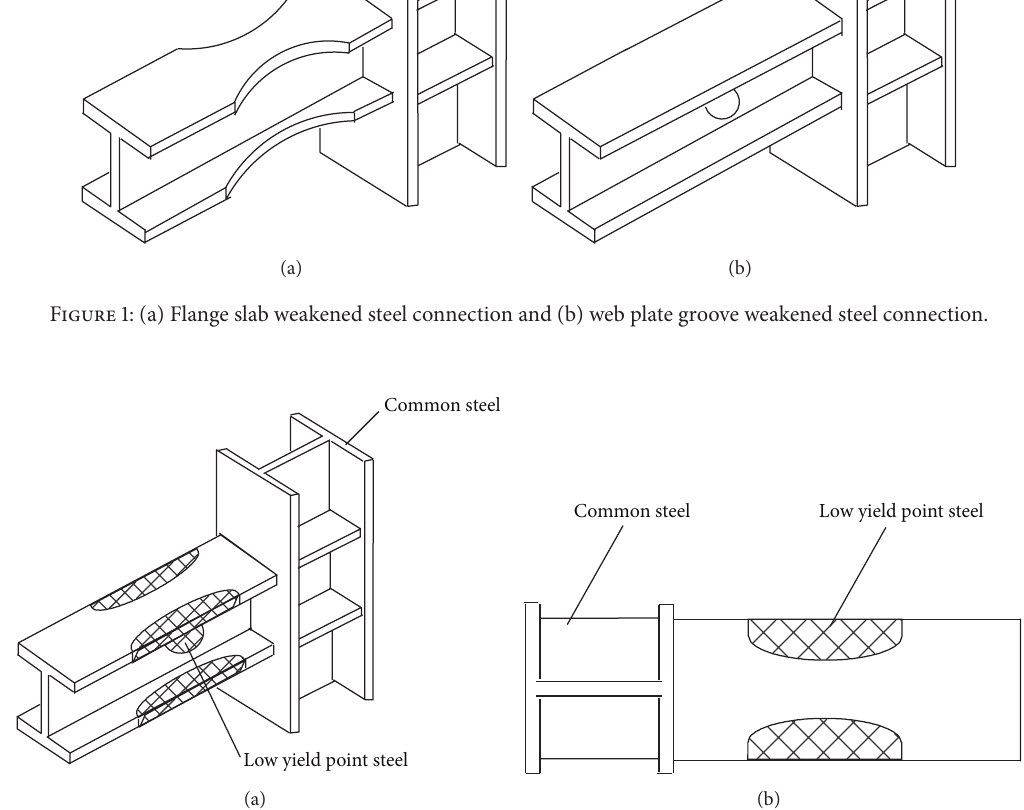
the beam, respectively, and the distance 𝑎 from the starting point of weakened zone to the column is set as 0.50 𝑏 𝑓 ∼ 𝑏 is 0.65 ℎ ∼0.85 ℎ 0.75 𝑏 𝑓 . The weakened length 𝑏 𝑏 , and the weakened depth 𝑐 is 0.20 𝑏 𝑓 ∼0.25 𝑏 𝑓 ; the radius of the hole ∼0.375 ℎ 𝑅 is 0.25 ℎ 𝑏 𝑏